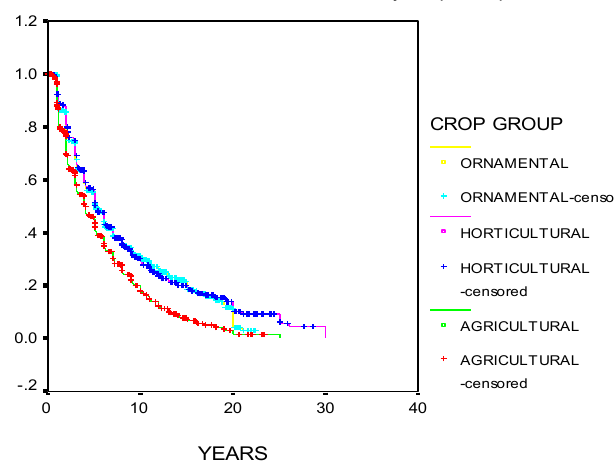
Figure 2. Kaplan-Meier Product Limit Estimates of Survival Function of PVP Certificates of Different Crop